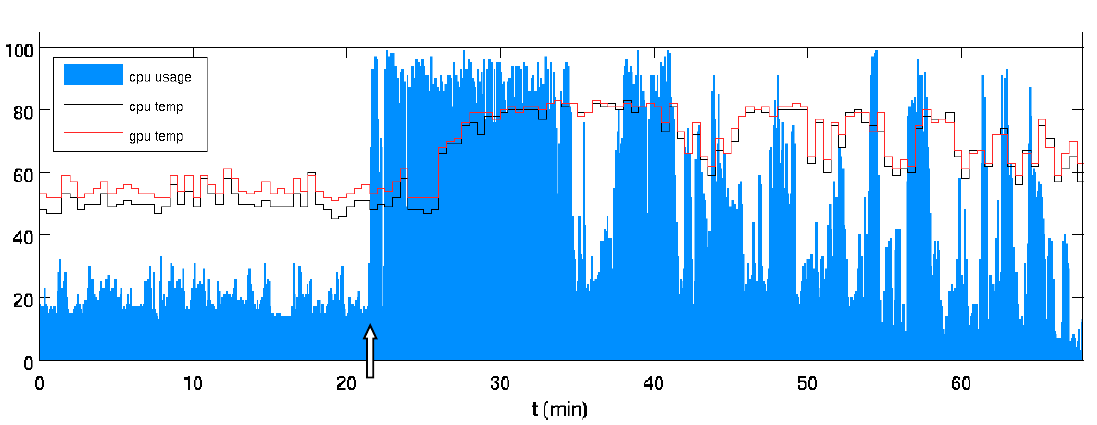
Figure 1. Microprocessor activity and CPU/GPU temperature.